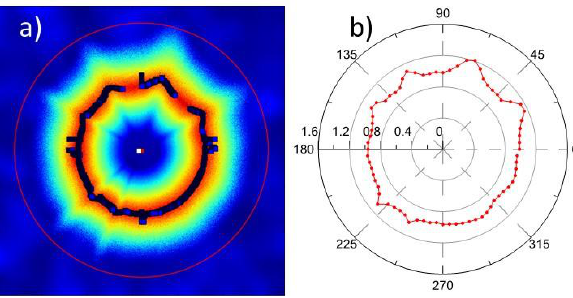
Fig. 2. Example of synthetic image (a) with identified valid maxima, center and outer boundary, and corresponding circumferential profile (b).